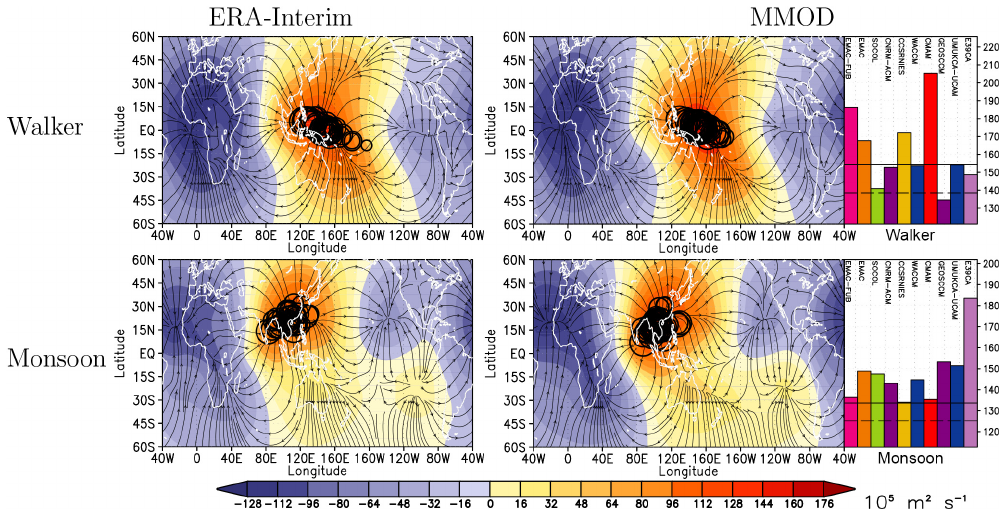
Figure 6. Top: Annual mean climatology of the MMOD χ ∗ (x,y) (velocity potential at 150hPa after subtracting the zonal average), repre- senting the divergent flow associated with the Walker circulation; (left) for ERA-Interim (1979–2014); (right) for the multi-model average of the CCMs. Bottom: JA climatology of χ ∗(cid:48) (t,x,y) (the velocity potential at 150hPa after subtracting the zonal average and annual average), representing the divergent flow associated with the ASM. Black circles mark the position of the maximum velocity potential for individual years. The bar charts on the right indicate the maximum climatological velocity potential for the individual CCMs; the solid horizontal line represents the MMOD and the dashed horizontal line represents the maximum of